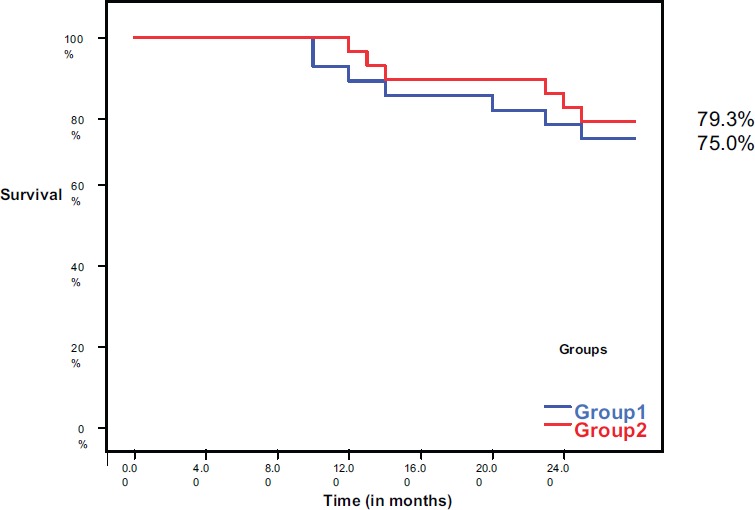
Overall survival in both groups.